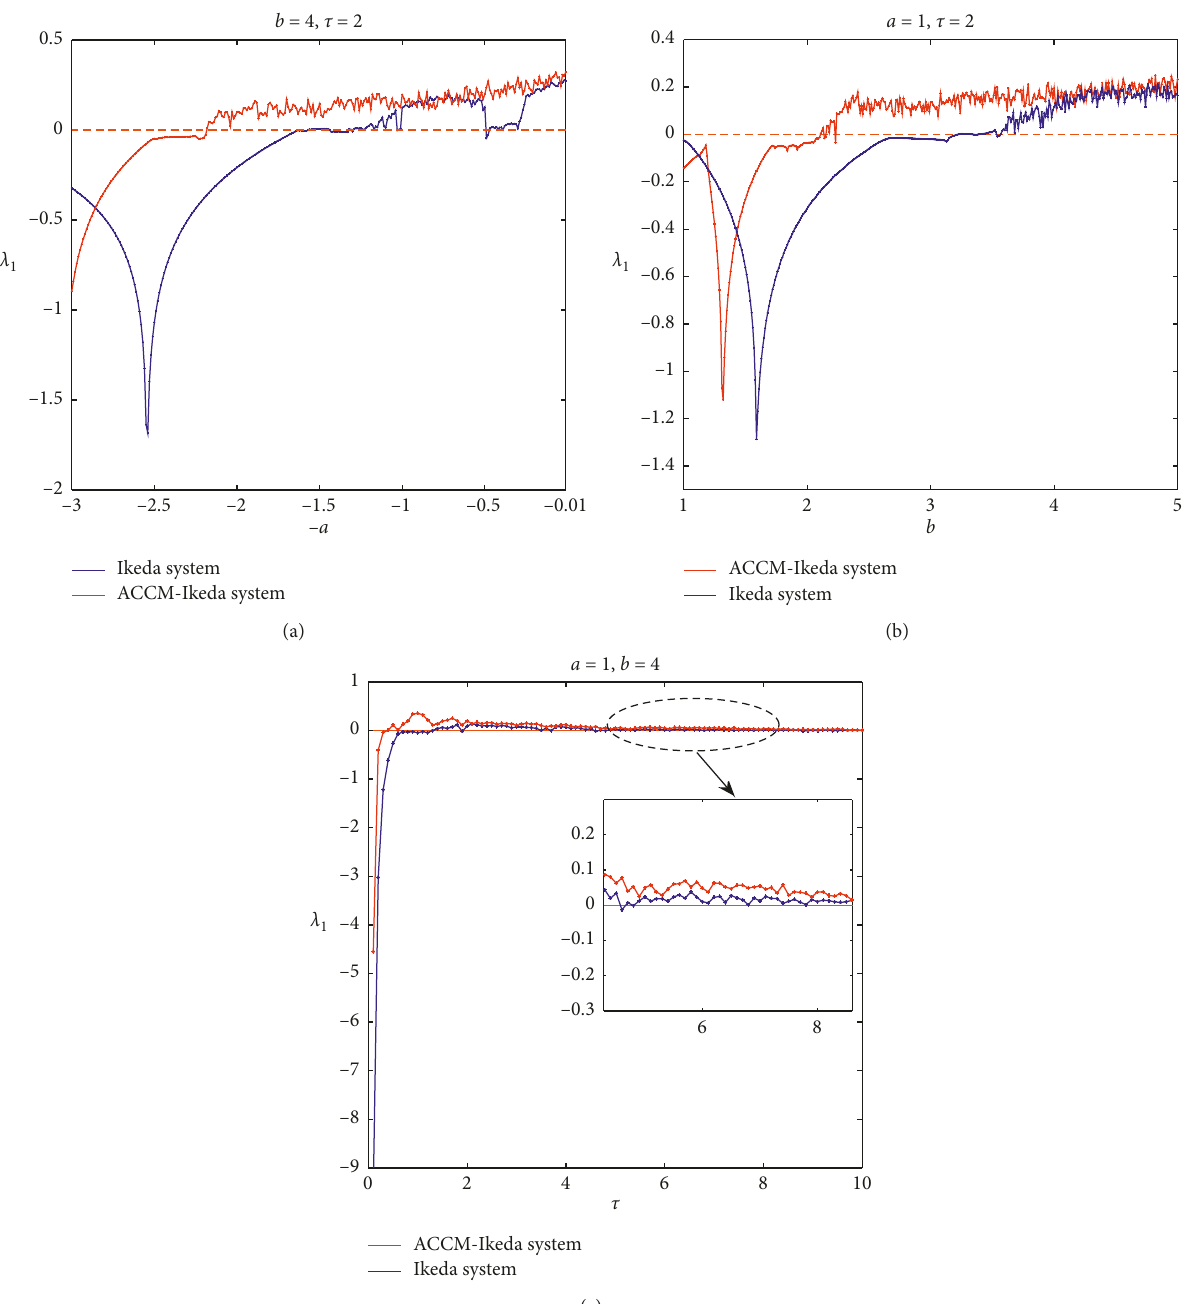
Figure 14: The first largest LEs comparisons of the ACCM-Ikeda TD system (2) and the seed Ikeda TD system (1): (a) LLE ( λ for bifurcation parameter a ; (b) LLE ( λ